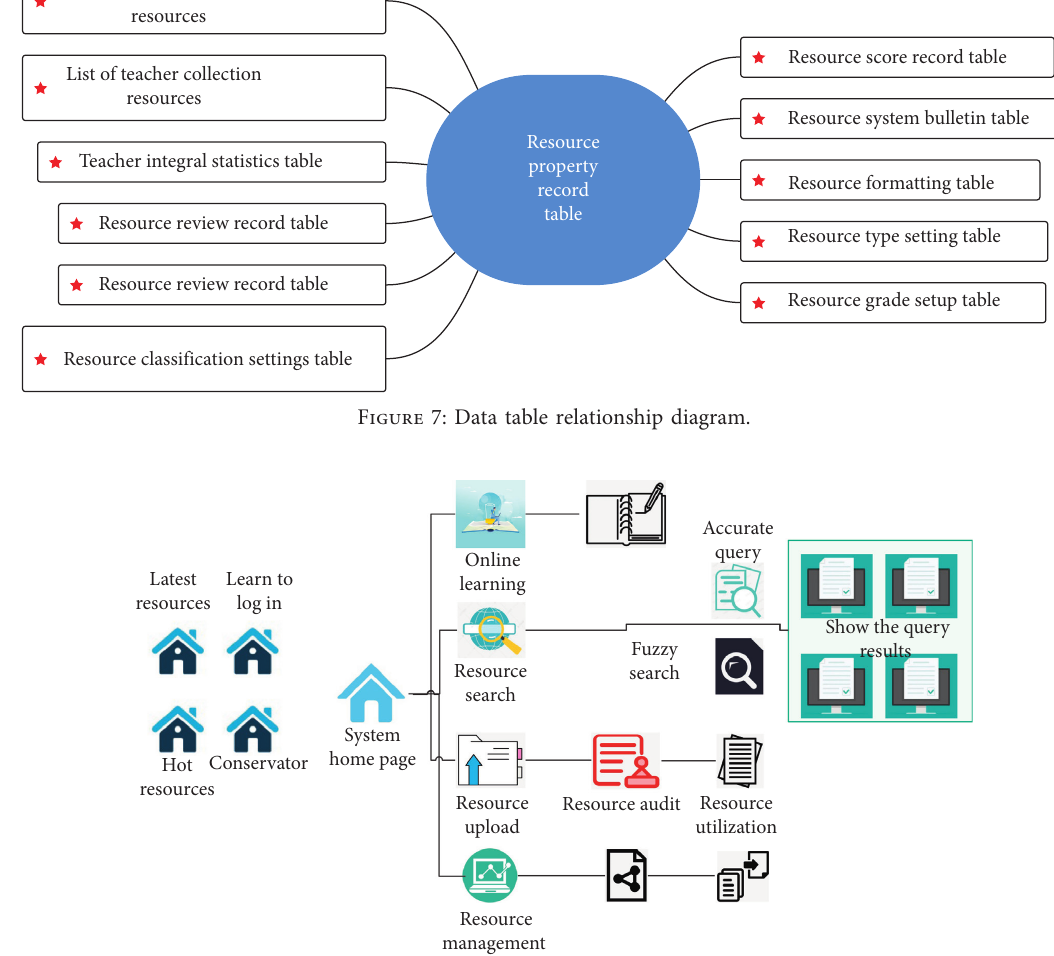
Figure 8: System module